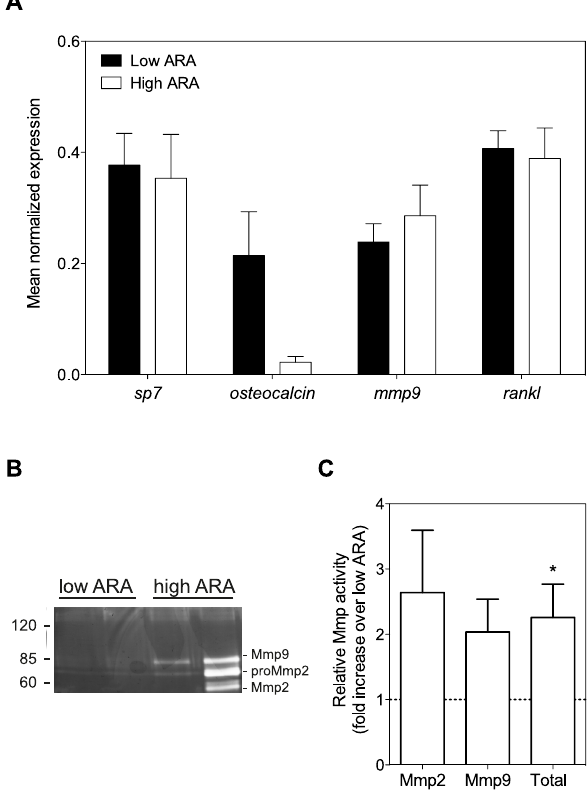
Figure 3. Gene expression profile and Mmp activity of ontogenetic scales after feeding the different diets. A : Gene expression analysis of ontogenetic scales from fish fed the low ARA diet (black bars) or the high ARA diet (white bars). No statistically different effects of the different diets were observed, not even in osteocalcin expression (P=0.900; non-parametric test). Transcript abundance is expressed relative to an index of the reference genes rpl13a and tuba1 . Results are displayed as means 6 SEM of 16 scales randomly obtained from all of the 4 replicate tanks. B : Example of a Coomassie-stained gelatin gel showing increased MMP activity in ontogenetic scales from the high ARA group (two lanes to the right) compared to the low ARA group (left lanes). Protein mass ladder is given in kiloDalton (kDa). C : Semiquantitative analysis of gelatinolytic activity demonstrates that total of Mmp2 and Mmp9 activity, secreted by cultured ontogenetic scales, is higher in scales from fish fed the high ARA diet compared to the low ARA diet. The total amount of secreted gelatinolytic activity is significantly increased in the high ARA group (P , 0.05; One sample T test). Results of high ARA samples are expressed relative to low ARA samples analyzed on the same gel. Bars represent the mean 6 SEM of 8